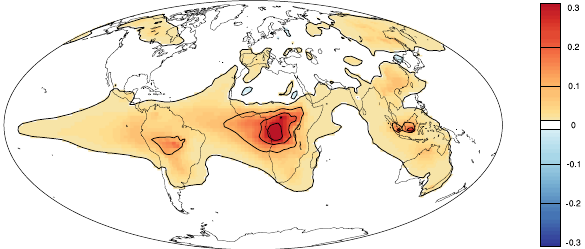
Fig. 4. Global map of aerosol optical depth anomalies (FIRE minus NOFIRE) from the CAM5 simulations. Averages were calculated using all 52yr from each simulation (and excluding the preceding spin-up periods). This applies to all remaining figures and